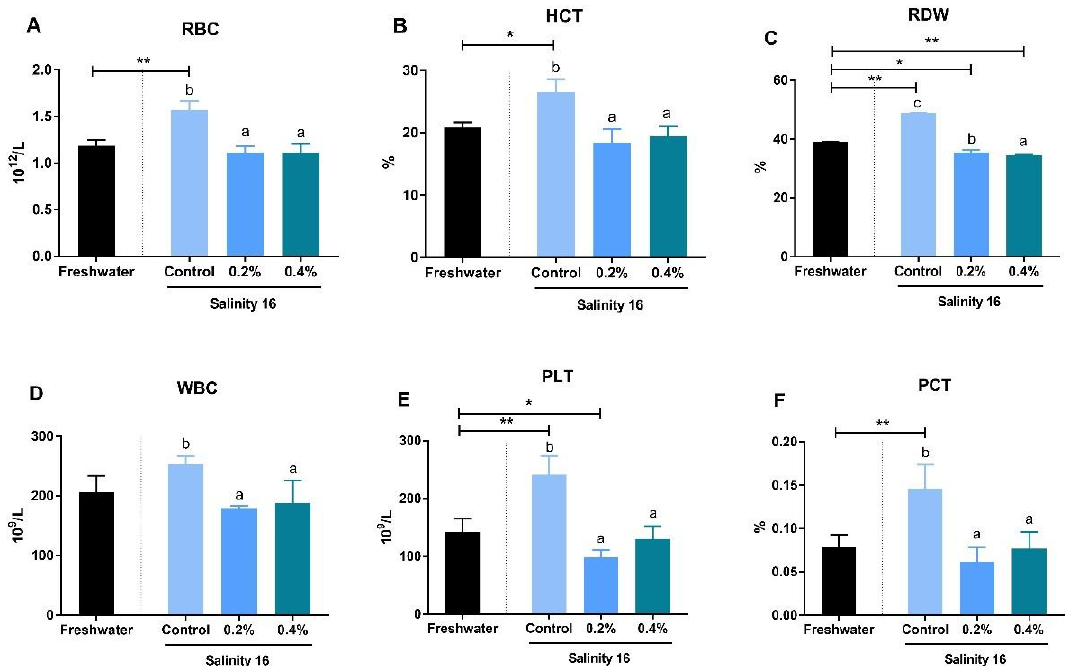
Figure 1. E ff ects of β -glucan supplementation on hematology in O. niloticus in freshwater and brackish water. Values are represented as mean ± SE. A single asterisk (*) indicates a significant di ff erence ( p < 0.05), and two asterisks (**) indicate an extremely-significant di ff erence ( p < 0.01). ( A ) red blood cell count (RBC); ( B ) hematocrit (HCT); ( C ) red cell distribution width (RDW); ( D ) white blood cell count (WBC); ( E ) platelet count (PLT); and ( F ) plateletcrit (PCT). Di ff erent letters with a–c indicated significant di ff erences among three treatments in 16 salinity water ( p < 0.05).